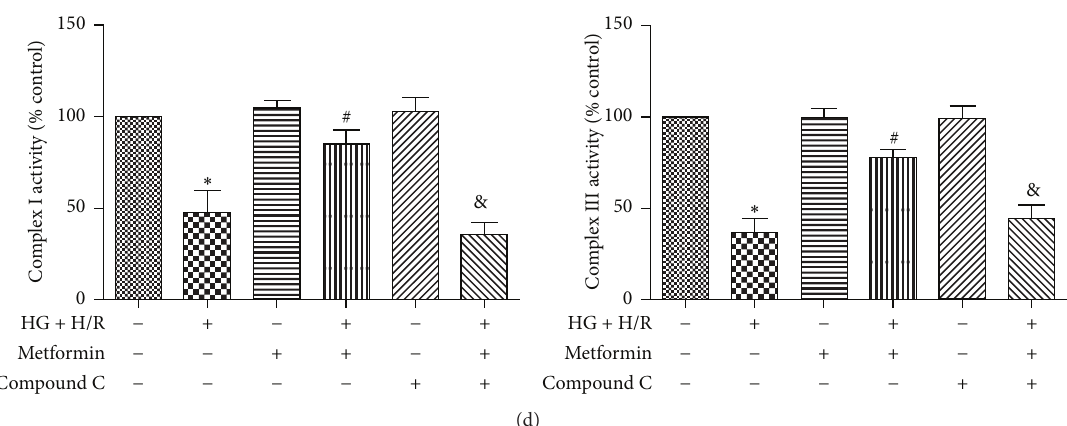
Figure 3: Metformin attenuated HG + H/R induced decrease in cell viability by preservation of mitochondrial membrane integrity and mitigating oxidative stress. H9C2 cells were treated with HG + H/R, metformin (5 mM), metformin + HG + H/R, compound C (1 𝜇 M), and metformin + HG + H/R + compound C. (a) Mitochondrial membrane potential evidenced by JC-1 staining. (b) ROS generation was measured by the DCF fluorescence intensity. (c) Bars represent quantified ROS generation. (d) Mitochondrial electron transport chain complex I and complex III activities were measured with commercial kits. ∗ 𝑃 < 0.05 versus control; # 𝑃 < 0.05 versus HG + H/R; & 𝑃 < 0.05 versus metformin + HG + H/R. Data in the bar graphs are calculated as means ± SD of 3 independent experiments.